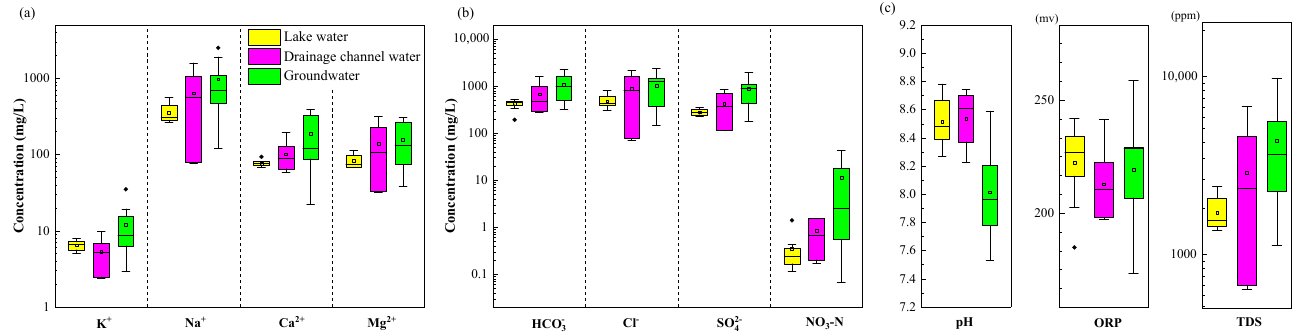
Figure 2. Boxplot of the hydrochemical indices (( a ): K + , Na + , Ca 2+ , and Mg 2+ ; ( b ): HCO − ORP and TDS) of the three water bodies (lake water, drainage channel water and groundwater).